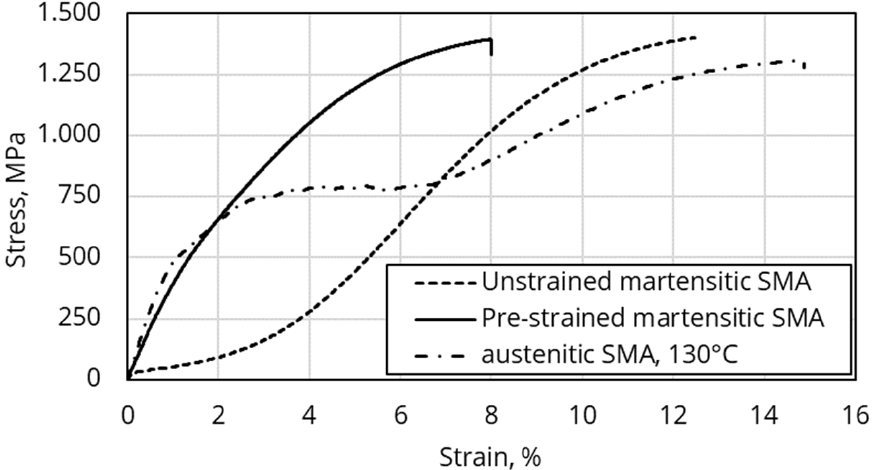
Figure 12. Tensile test of pre-strained as well as unstrained martensitic SMA at room temperature and austenitic SMA at 130 ◦ and austenitic SMA at 130 °C.